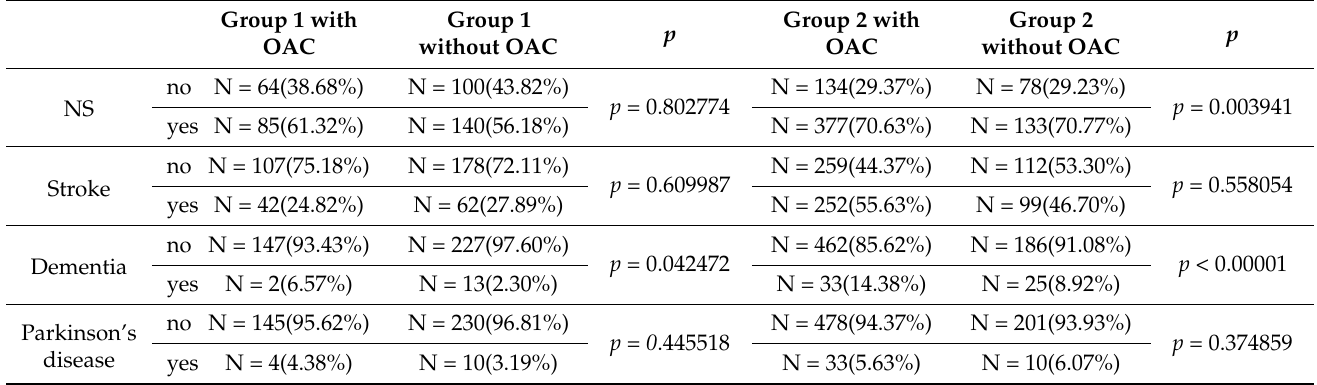
Table 10. Impact of oral anticoagulants in the appearance of overall neuro-psychiatric complications, stroke, dementia, and Parkinson’s disease in paroxysmal and permanent AF patients (using Chi- square test).